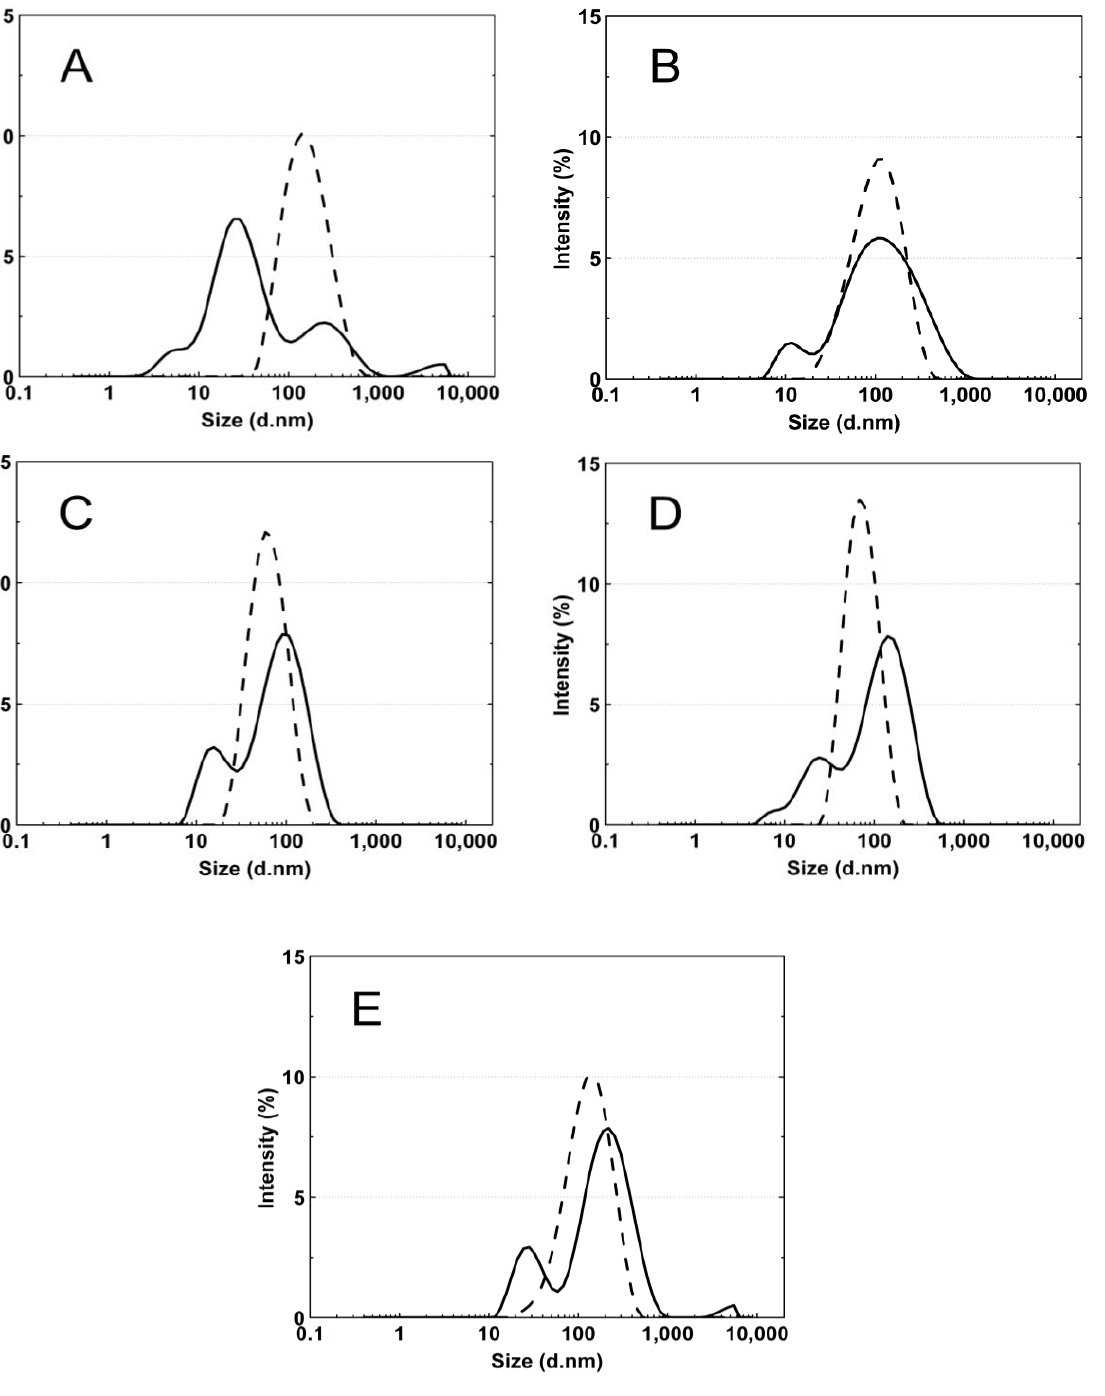
Figure 8. The particle size distributions by intensity for P1 ( A ), P2 ( B ), P3 ( C ), P4 ( D ), and P5 ( E ) dispersions at 18 ◦ C—solid line; 45 ◦ C—dash line; these were obtained by dynamic light scattering dispersions at 18 °C — solid line; 45 °C — dash line; these were obtained by dynamic light scattering (DLS) (DLS) analysis.